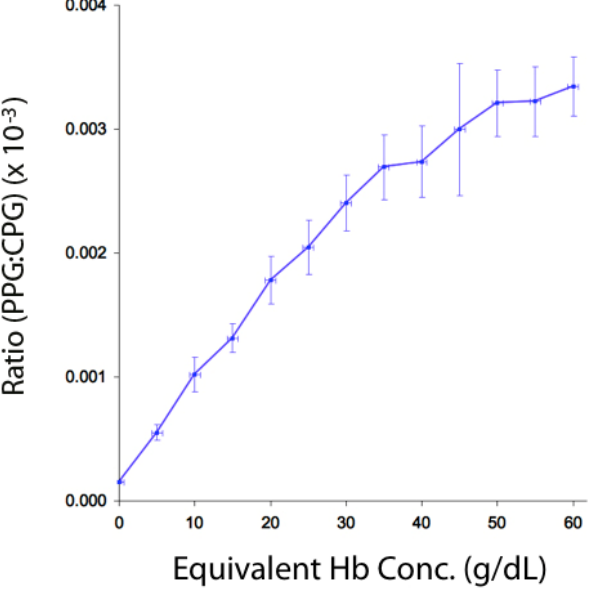
Figure 7. Graph of ratio of mean (±SD) normalized amplitudes (PPG:CPG ratio) plotted against equivalent blood hemoglobin (Hb) concentration.